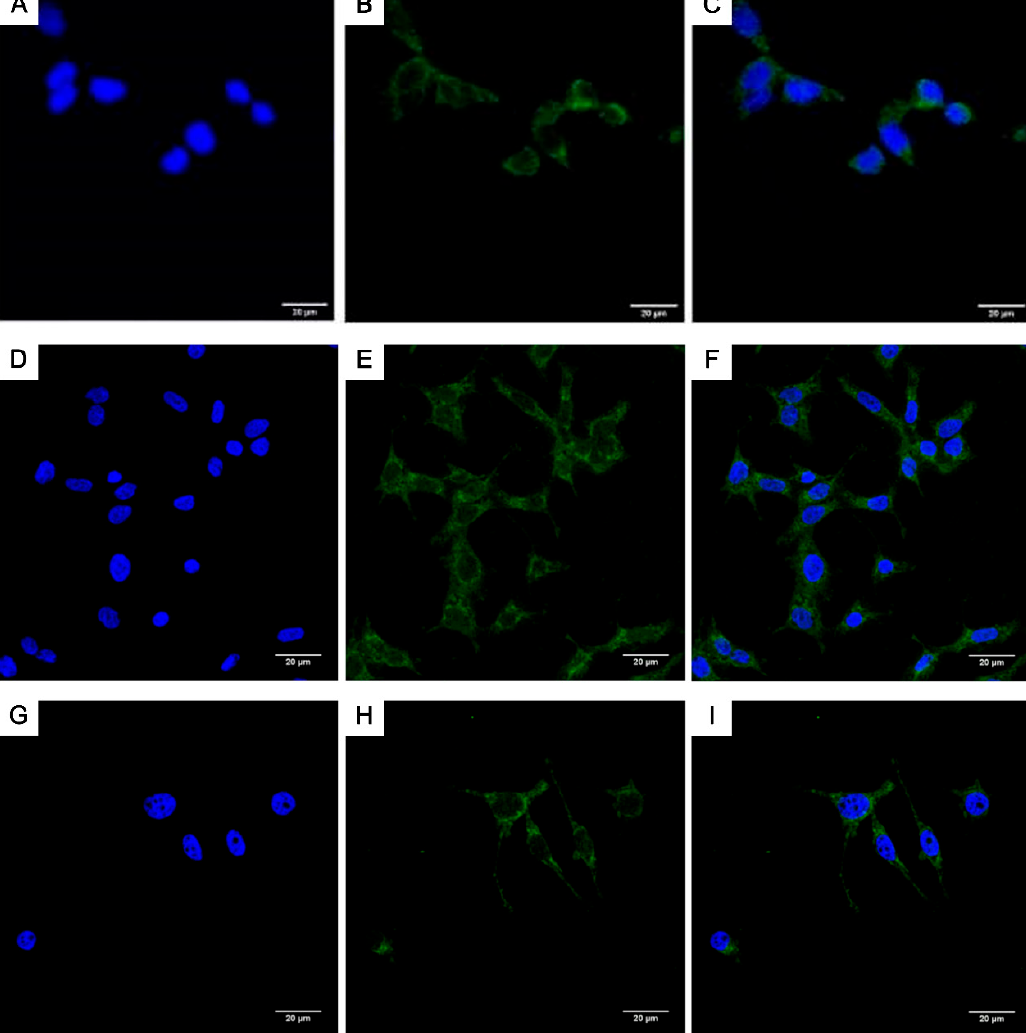
Figure 7. FRs analysis (CLSM) of LoVo cells incubated for 48 h ( A – C ) alone (control), and with ( D – F )